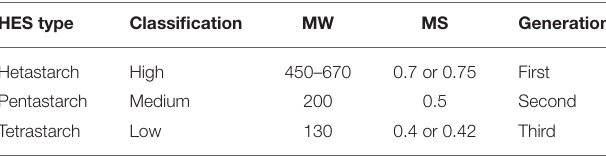
TABLE 1 | Common different HES types and their physicochemical